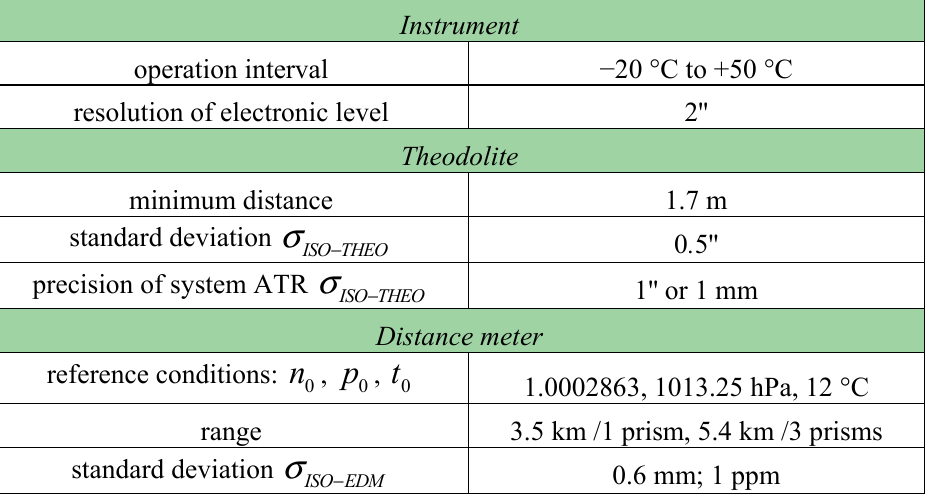
Table 2. Main technical characteristics of the Leica Geosystems TS30 total station.